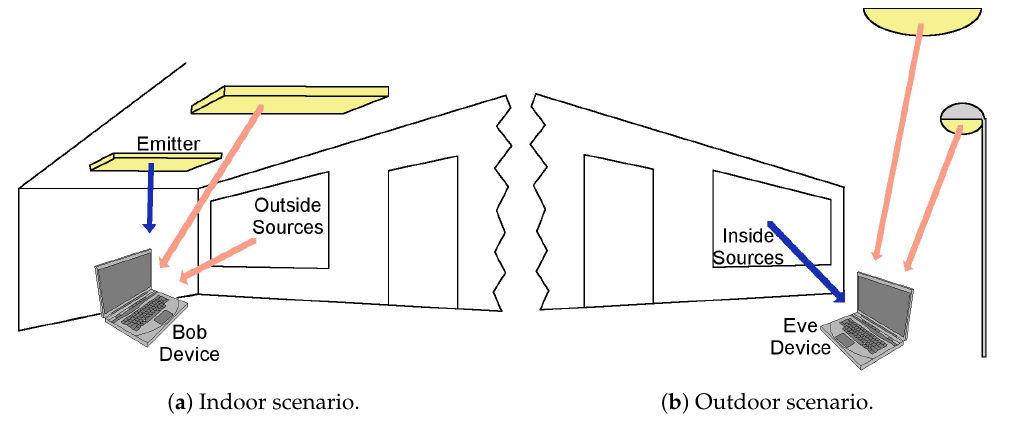
Figure 2. Indoor and outdoor examples of noise sources. In ( a ), two interference sources are present: non Visible Light Communication (VLC) light fixtures and the light coming through a window; in ( b ), two interference sources are present: the non-VLC street light and the